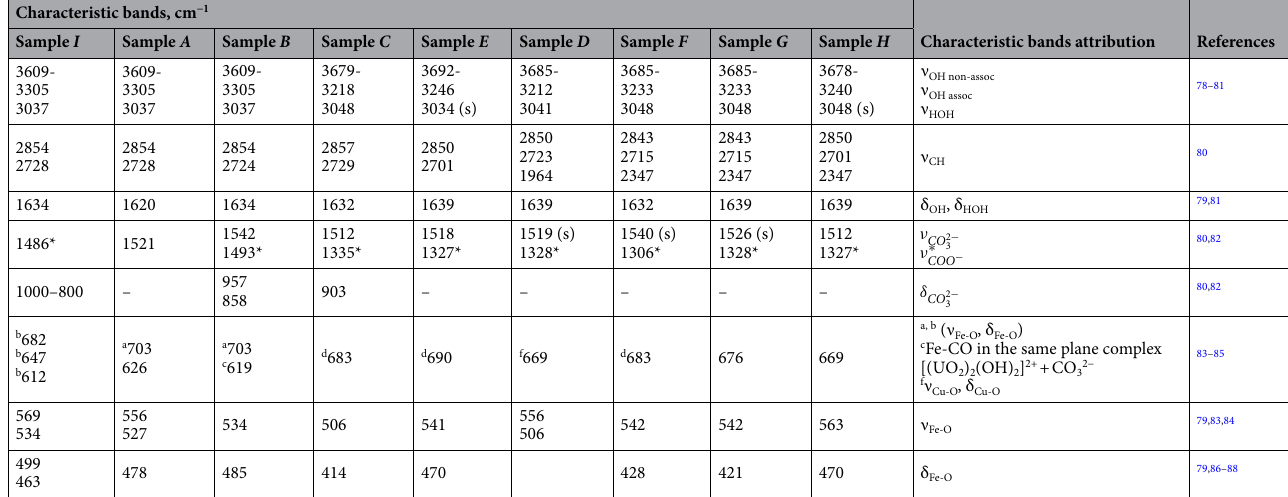
Table 2 shows the sublates’ thermal analysis’ results obtained after the separation by sorption/precipitate flotation of U(VI) from Cr (VI), Cu (II), and Mo (VI). The analysis of TG/DTG/DTA curves shows the sublates’ non-iso-thermal degrading process in the air atmos- phere in the case of the bi-, three- and tetra component systems. The samples were subjected to three successive decomposing and water loss processes (Table 2). The first endothermal process (20–120 °C) points out moisture’s complete loss. The analysed samples present similar moisture. The weight losses in this stage are about Δm 1 = 4.57–6.21% at the maximum temperatures within the range 97.1–109.3 °C. The samples seem to be stable within the temperature range of 120–250 °C. Then the second decomposition process follows, which is exothermal (250–350 °C) and represents the main degrading stage with the weight loss Δm 2 = 6.14–8.07% at the maximum temperatures within the ranges 273.0–281.0 °C and 304.1–347.5 °C, respectively. At higher temperatures (350–900 °C) the last exothermal process of thermal-oxidative decomposition of non-volatile products was obtained in the second degrading stage. In all cases for the temperatures ranging within 513.7–620.9 °C the similar residual weights Δm 3 = 1.35–2.06% point out the studied metallic ions’ oxides’ mixtures’ occurrence. Reproducibility and optimal parameters validation on real mine water samples. Reproduc- ibility of U(VI) removal by sorption/precipitate flotation. Previously determined sorption/precipitate flotation technique optimal parameters were examined on 10 identical sample solutions (C o = 10 mg/L) corresponding to two different molar ratios ([U(VI)] : [Fe (III)] : [NaOL] = 1 : 75 : 1 × 10 –2 and 1 : 100 : 1 × 10 –2 ), respectively, to calculate the U(VI) removal reproducibility by Student method (Table 3).